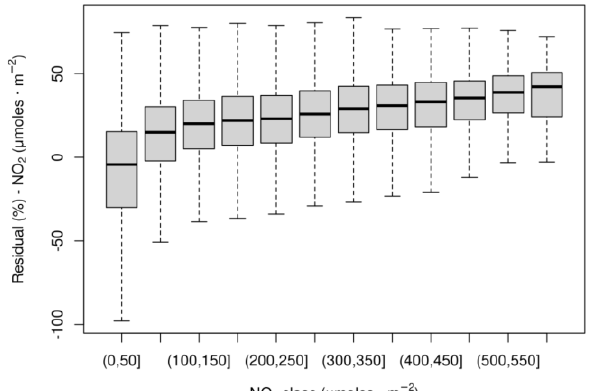
Figure 5. Residuals distribution divided in classes of NO2 values.